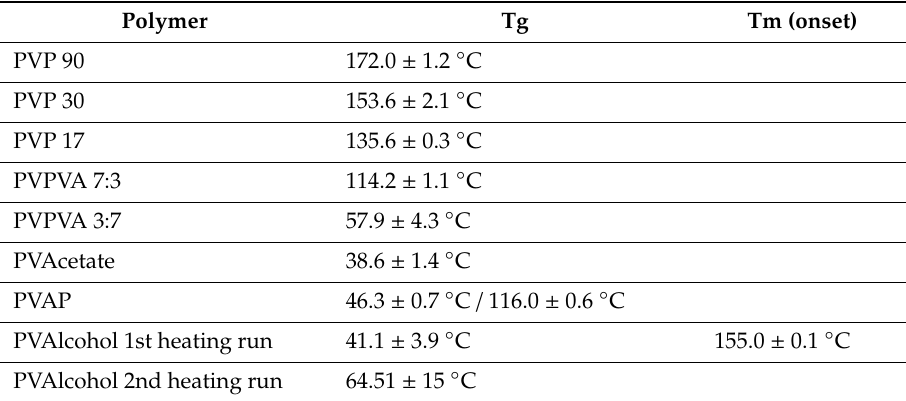
Table 2. Thermal event values ( ± standard deviation) of raw materials.